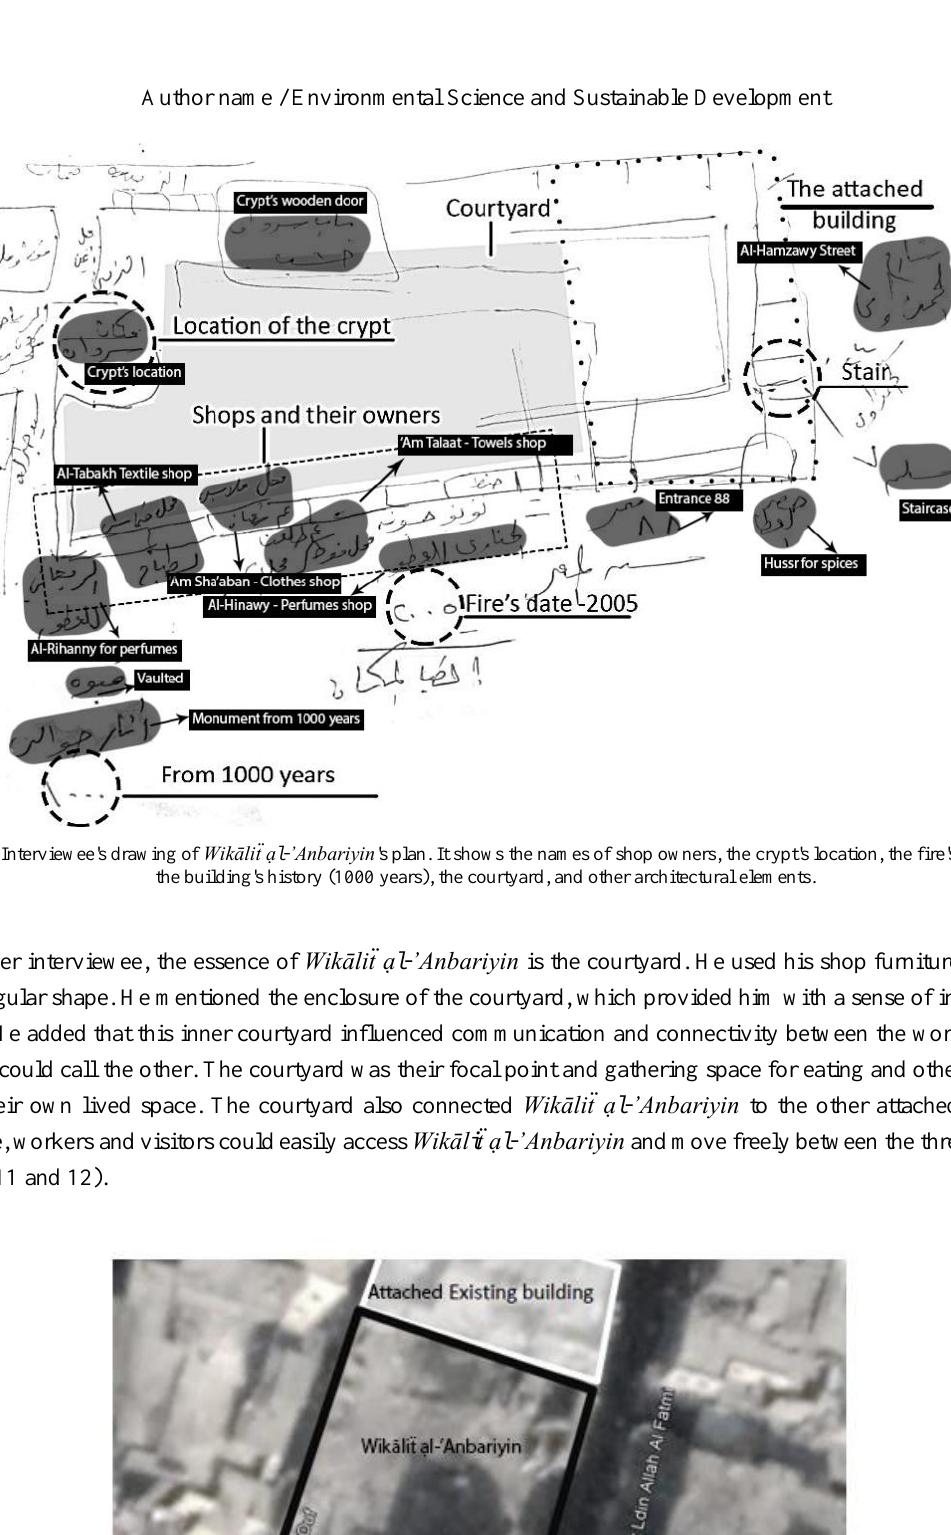
Figure 11. The black continuous line indicates the location of Wikāliẗ ạl - ’Anbariyin . The white rectangles indicate the attached existing